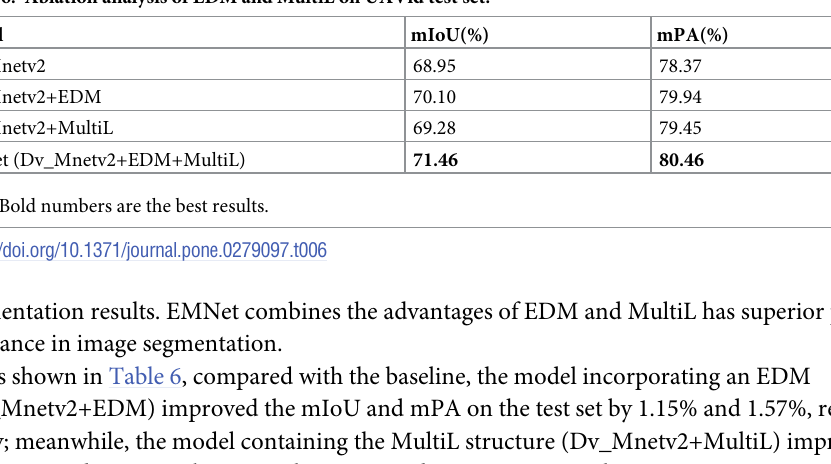
Table 6. Ablation analysis of EDM and MultiL on UAVid test